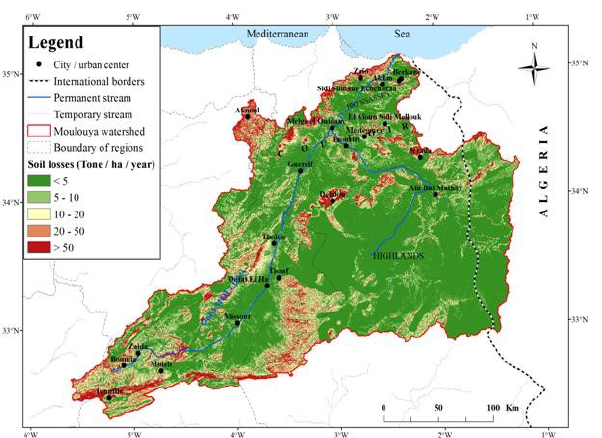
Figure 2. Soil erosion map (created by us based on layers of https: //www.openstreetmap.org/, last access: March